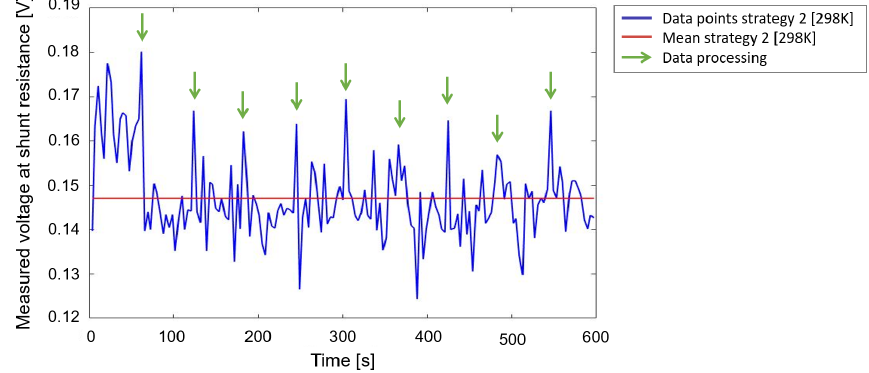
Figure 6. Operation strategy 2 at microcontroller 1.